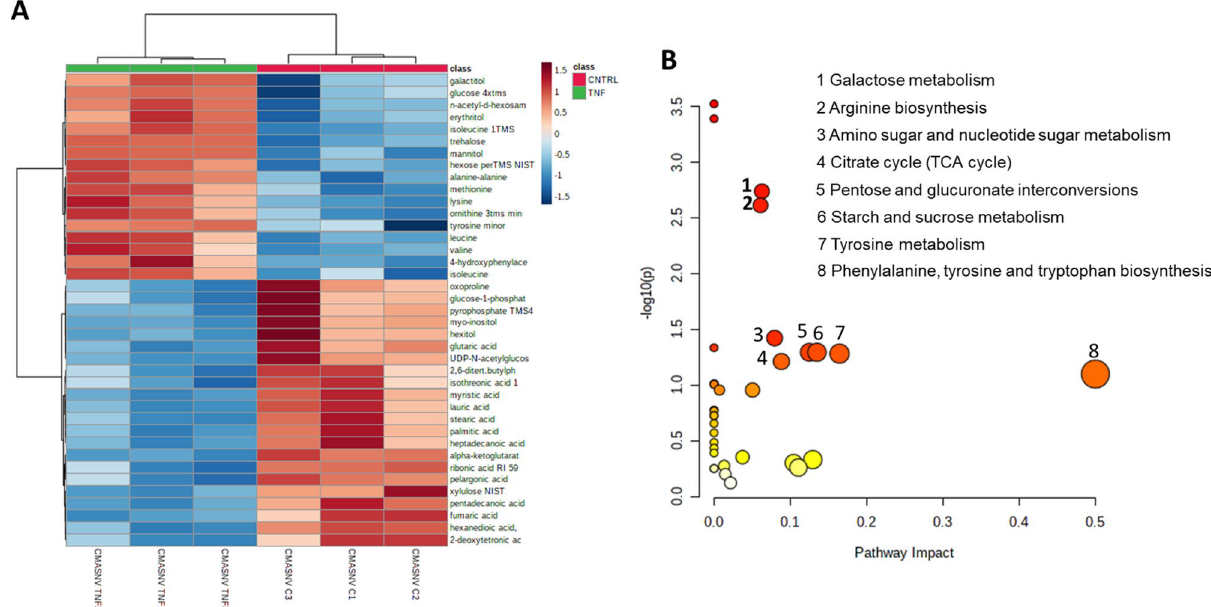
Figure 1. Metabolic changes in bFLS induced by bTNF-α. ( A ) Clustered heatmap of the metabolite profile changes induced by bTNF-α in bFLS. Rows represent specific intracellular metabolites, and columns represent the conditions. n = 3. ( B ) Overview of principal metabolic pathways induced bTNF-α in